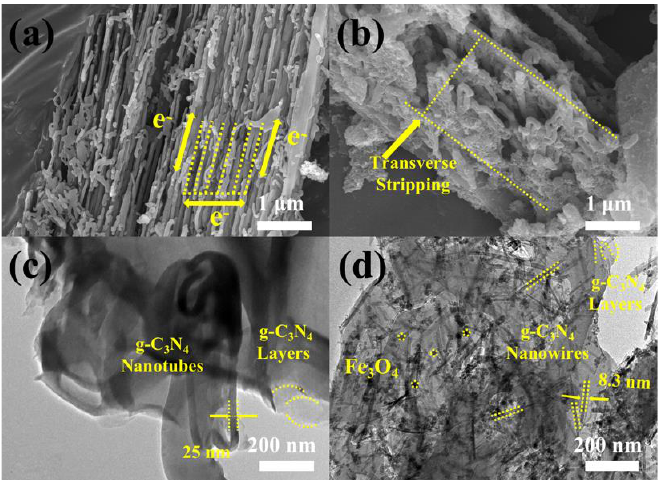
Figure 1. The g-C 3 N 4 SEM images of ( a , b ) at different viewing angles and TEM images of ( c ) g-C 3 N 4 and ( d )